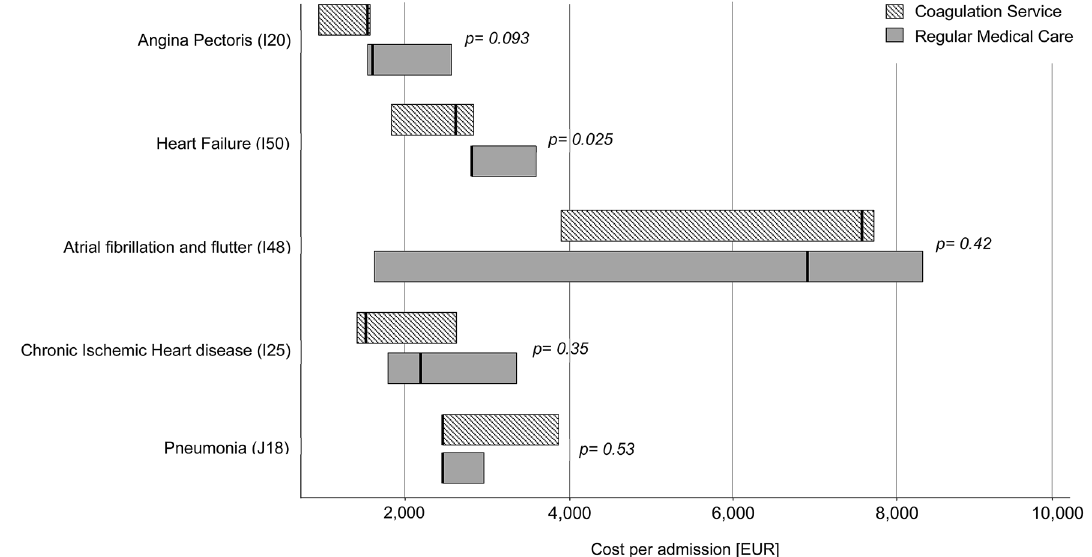
Figure 2. Median costs of hospitalizations for the five most common ICD-principal diagnoses stratified by healthcare model.